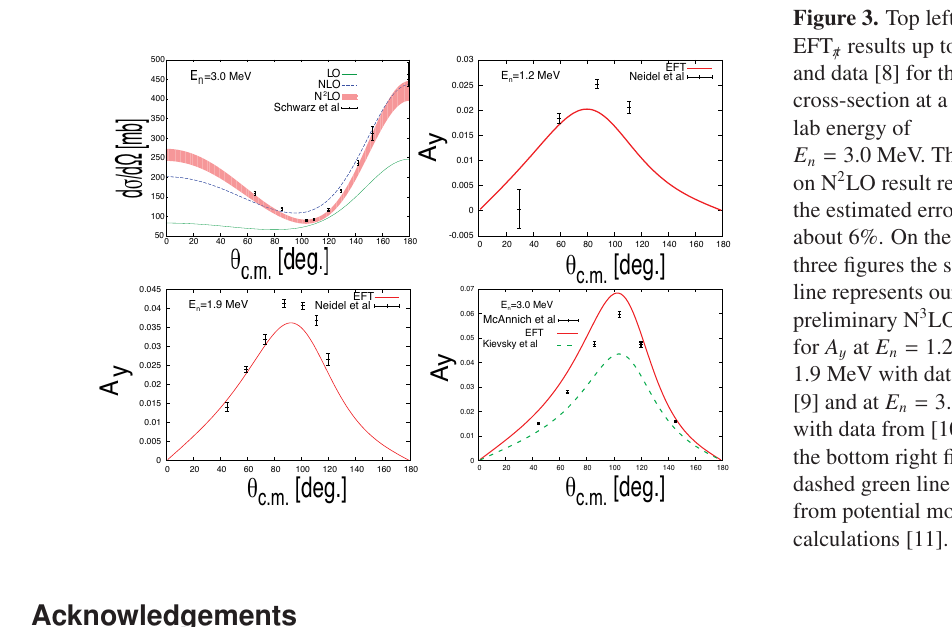
Figure 1. Thin line is nucleon propagator, double line is dibaryon propagator. For m = 1 ,..., n oval with an m is the m th order correction to the nd scattering amplitude, rectangle with an m is N m LO corrections that involve all three-nucleons, and this includes three-body forces, circle with m is the m th order correction to the dibaryon propagator. The solid red oval is the LO nd scattering amplitude. Figure 2. Diagram contributing at N 3 LO. The square is a two-body P -wave interaction vertex. This diagram is included in Fig. 1 in the rectangle with n = 3.